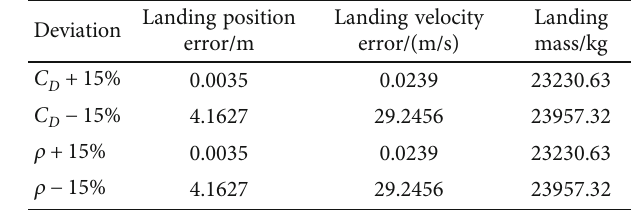
Table 8: Landing errors and masses of the guidance